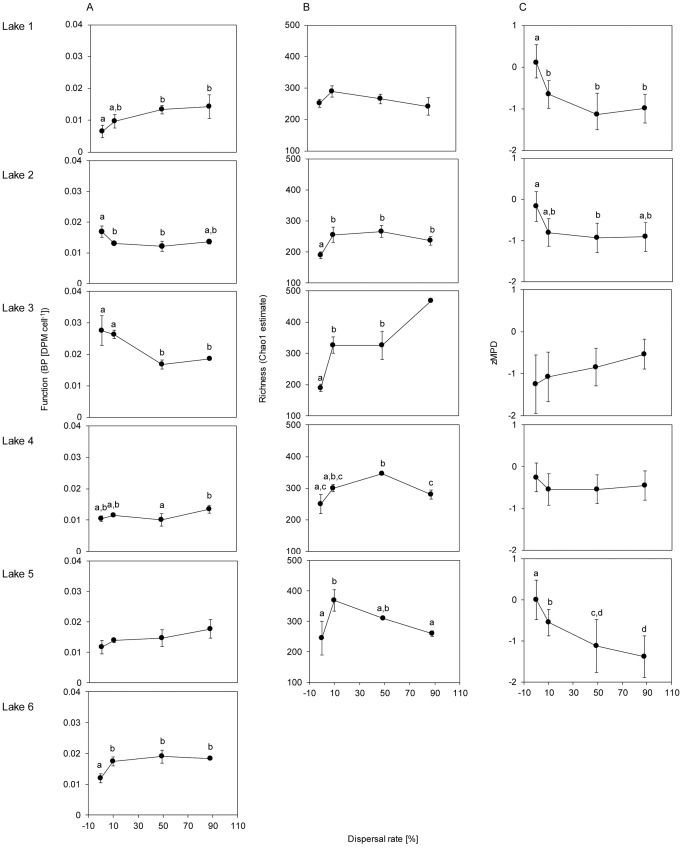
The influence of dispersal on community functioning (A), taxonomic (B) and phylogenetic diversity (C).Community functioning is assessed as per cell bacterial production (A), local richness of the bacterial community estimated by Chao1 (B), and average phylogenetic distance between bacteria in a community estimated as standardized effect size of MPD (C) for each lake (1–6) in relation to dispersal rate (I–IV). Error bars are standard errors of within treatment replicates in (A and B), and standard deviations calculated from 100 single trees in (C). No replicates were available for dispersal rate IV in lake 3 in (B). Lake 6 is missing in (B) and (C) because DNA could be extracted from dispersal rate I only. Bars with different letters denote significant differences between dispersal treatments within one lake, assessed form Tukey’s post-hoc test in one-way ANOVAs.